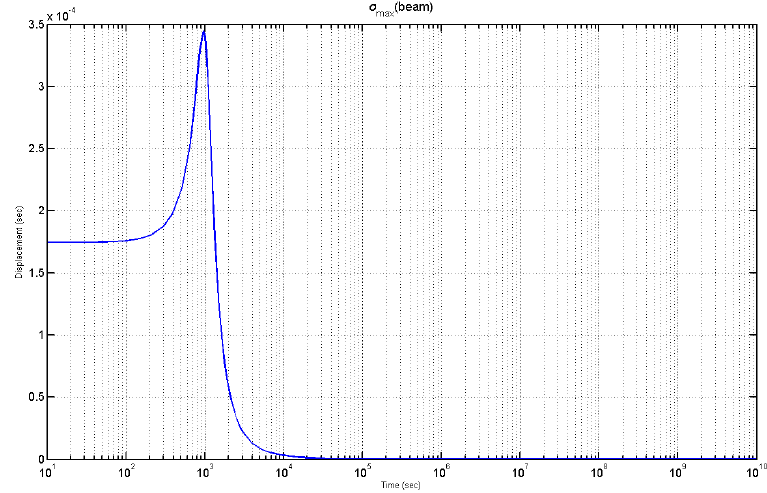
Figure 11. The robust performance criterion measure.